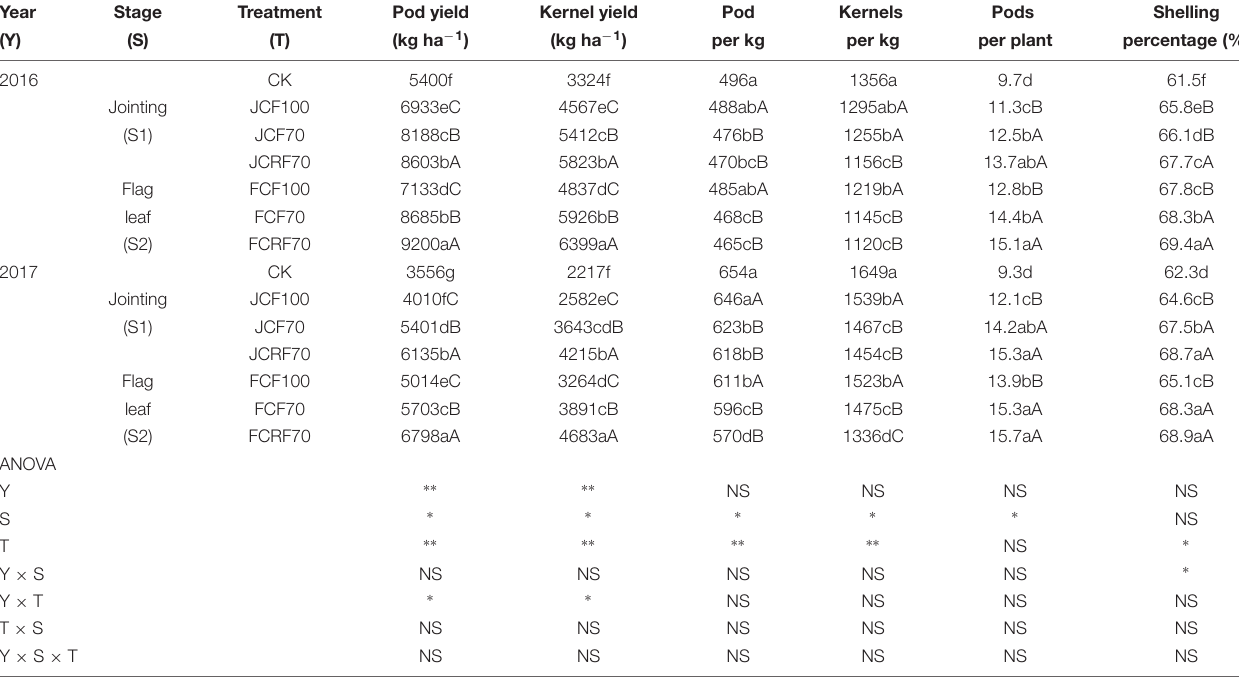
TABLE 7 | Peanut yield and yield components with different N fertilizer management